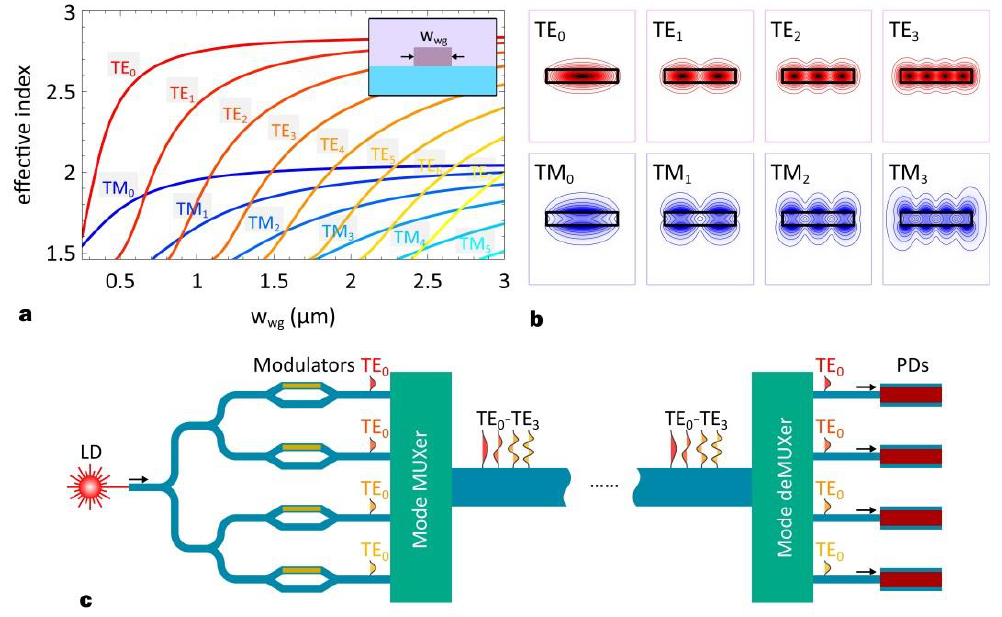
Figure 1. ( a ) The calculated effective indices for the higher-order modes in a silicon-on-insulator (SOI) waveguide with varied waveguide width (w wg ). The inset shows the cross-section of a multi-mode SOI waveguide with some key parameters labeled. ( b ) The calculated field profiles for the first four transverse electric (TE) and transverse magnetic (TM) modes. ( c ) The configuration for a typical four-channel mode-division multiplexing (MDM) system.